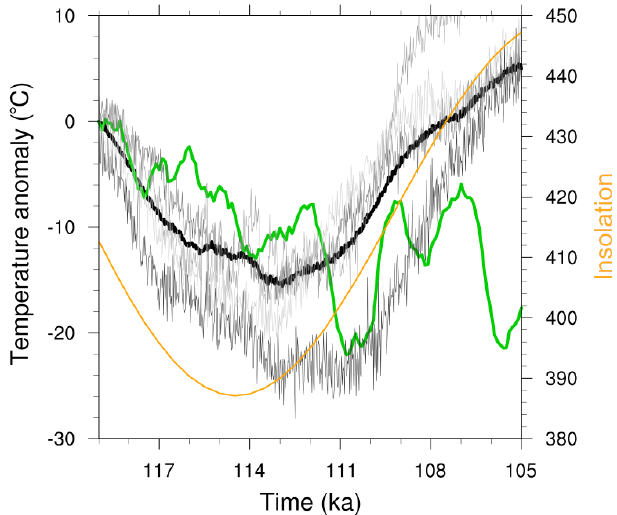
Figure 2. Annual mean 2m temperature anomaly relative to 119ka for the GRIP ice core (green) (Dansgaard et al., 1993; Tarasov and Peltier, 2003), ensemble mean (thick black), and three individual runs (grey lines). The orange line depicts the timing of insolation changes at 60 ◦